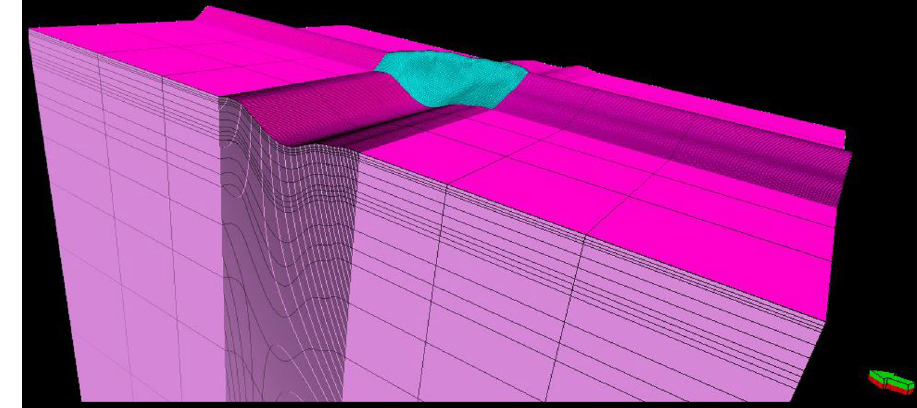
Fig. 7 Final geomechanical grid (green area reservoir, pink area surrounded geomechanical grid portion)